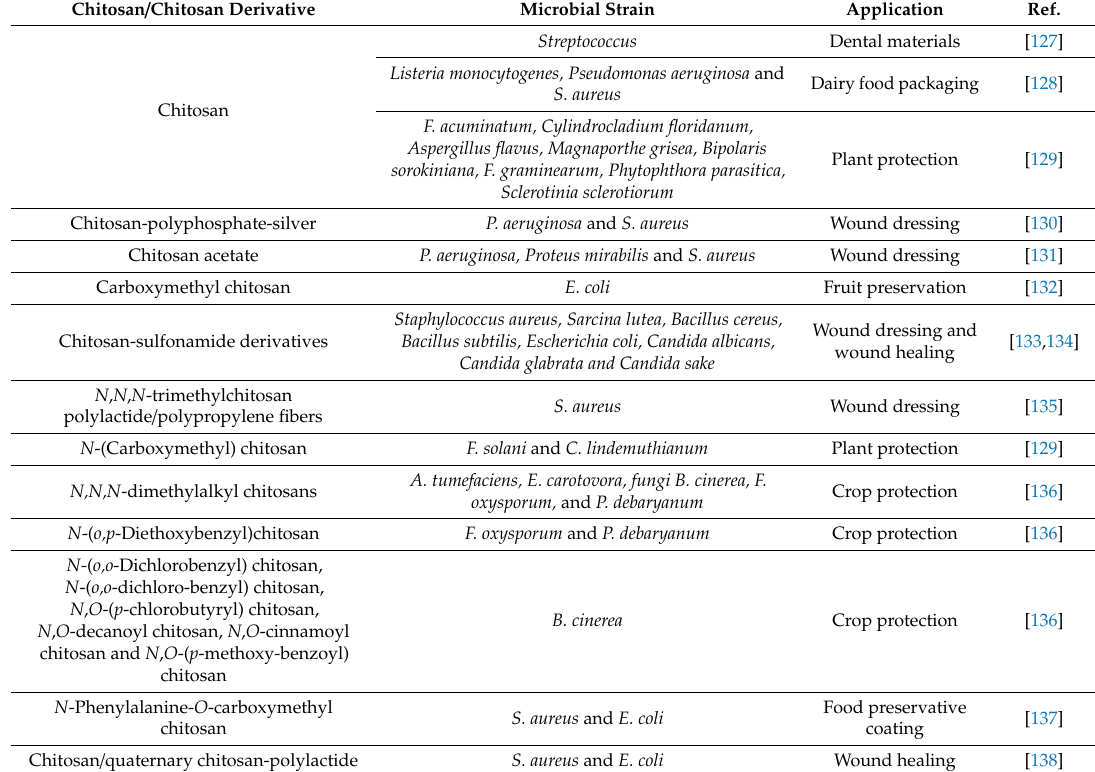
Table 8. Some microbial applications of chitosan and chitosan